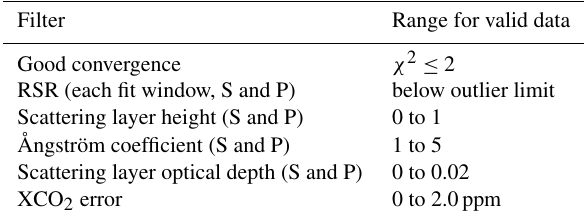
Table 8. Basic filter